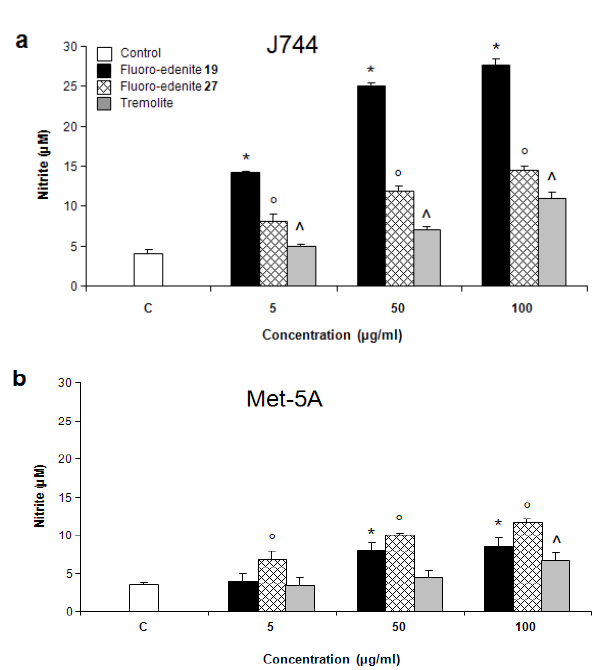
Figure 2: Release of nitrite from J774 (a) and Met-5A (b) cells quantified by colorimetric assay in the culture media. The values, expressed as nM/10 6 cells, are the mean ± SEM of three experiments performed in triplicate. All values with P<0.01 were considered significantly different and labelled by these symbols